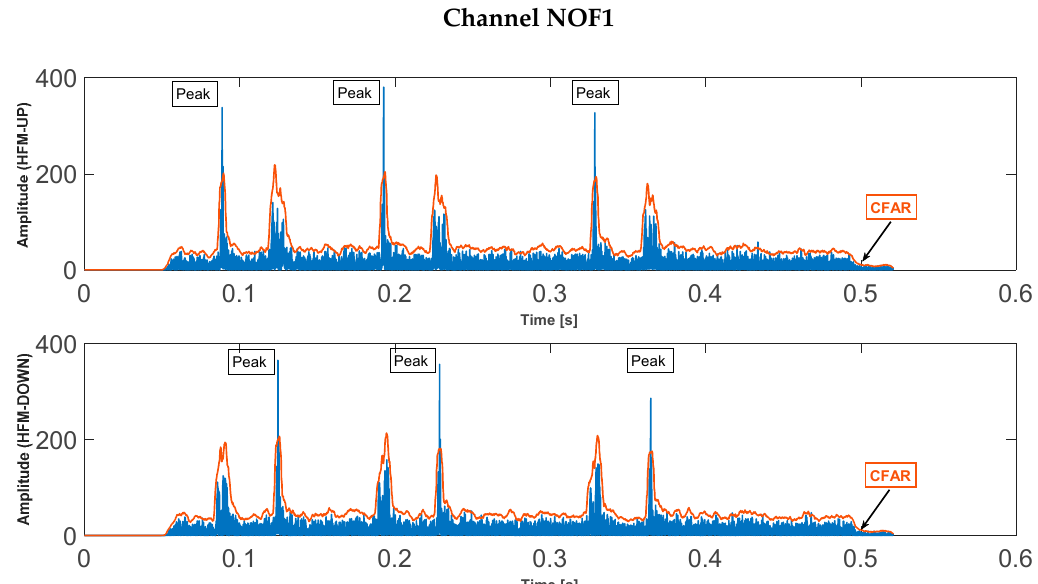
Figure 6. Correlation functions for the received signal on channel NOF1 (SNR = − 3 dB, T PS = 4 ms).